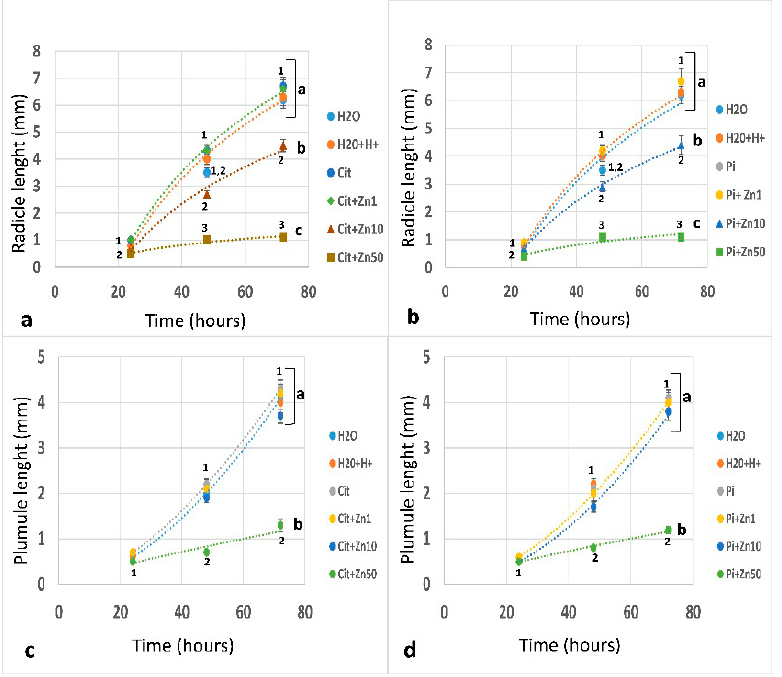
Figure 2. Effect of zinc on radicle and plumule growth. Maize embryos imbibed for 24, 48, or 72 h. ( a , c ): Effect of zinc at 1, 10, or 50 mM in the presence of 10 mM of Cit. ( b , d ): Effects of zinc at 1, 10, or 50 mM in the presence of 10 mM of Pi. There was a negative and significant effect on the radicle growth of embryos imbibed in Zn10 or Zn50 compared with the other conditions, while the expansion of the plumule was only affected by imbibition under Zn50. The data represent the mean ± SE of n = 40 to 60 independent data points. ANOVA was performed, followed by the Tukey–Kramer multiple comparison test, with p < 0.05 representing significance. Significant changes at each imbibition time for the different experimental conditions are indicated with different letters. Significant differences between experimental conditions during the imbibition interval (24 to 72 h) are indicated with lowercase letters.